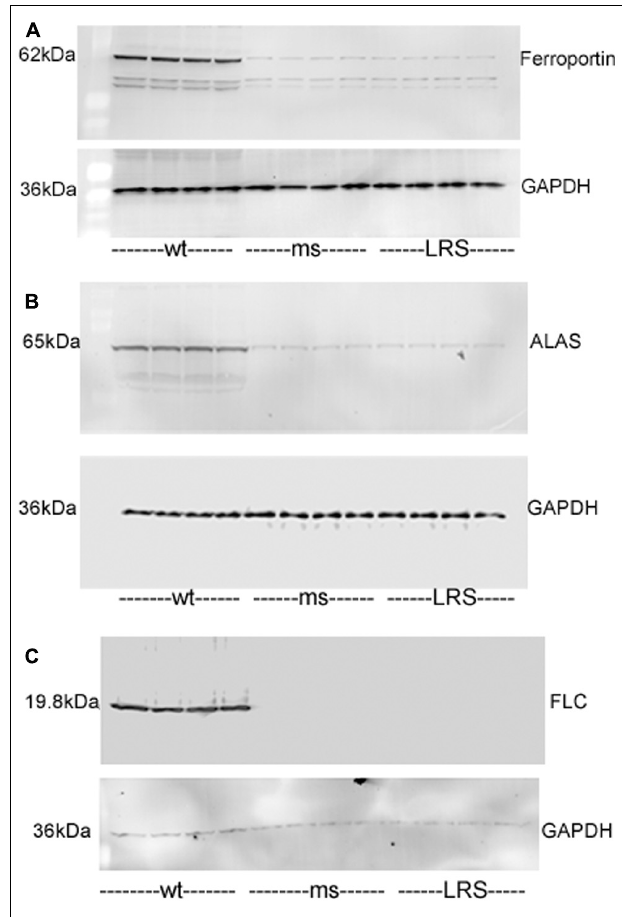
FIGURE 7 | Mouse ferroportin, 5-aminolevulinic acid synthase (ALAS), and ferritin light chain (FLC) proteins are increased in sickle mice overexpressing human wt-FHC. Proteins of subcellular fractions isolated from livers of wt-, ms-, and LRS-treated mice ( n = 4) were run on a western blot (30 ug protein/lane) and immunostained for (A) microsomal ferroportin, (B) mitochondrial ALAS, and (C) cytosolic